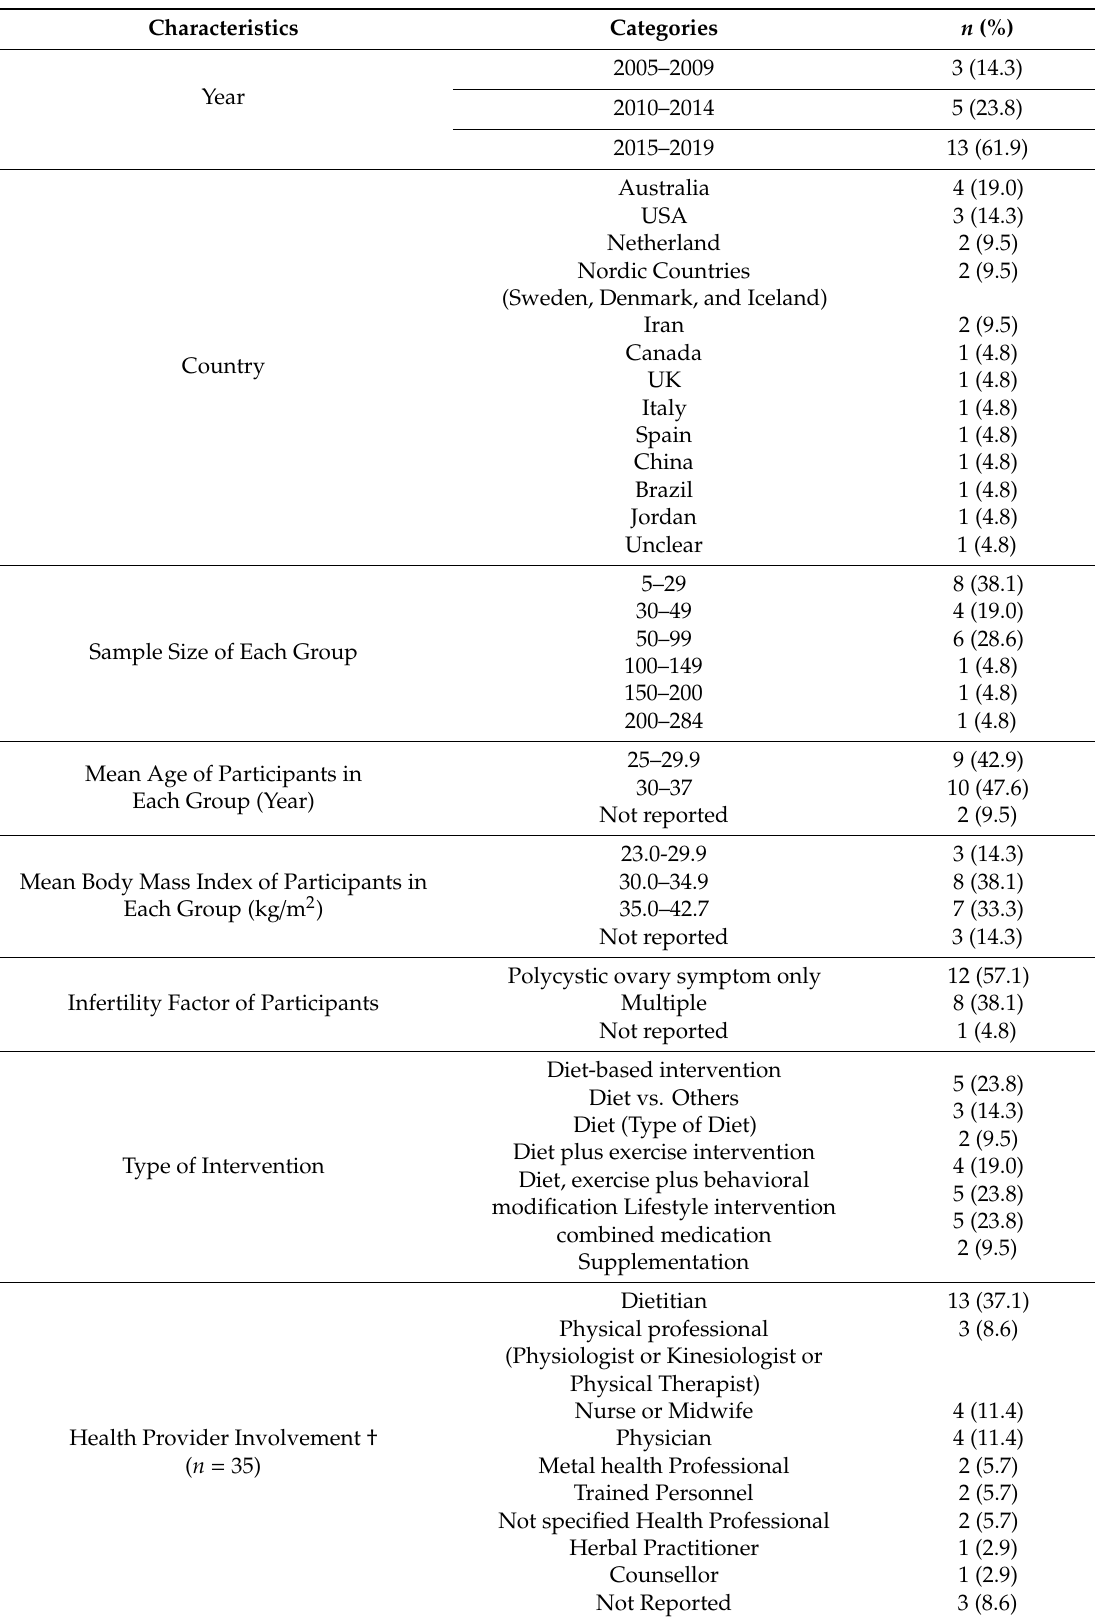
Table 2. Characteristics of the included studies ( n =